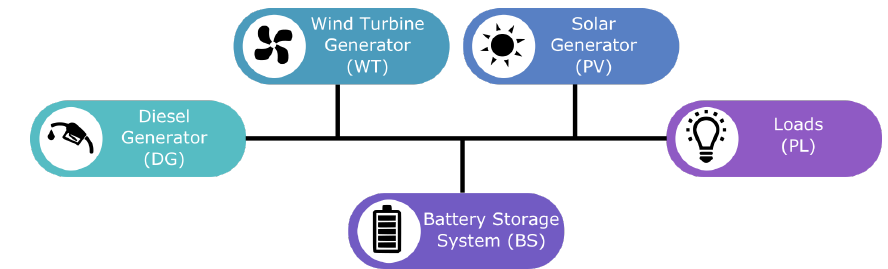
Figure 1. Hybrid power generation system